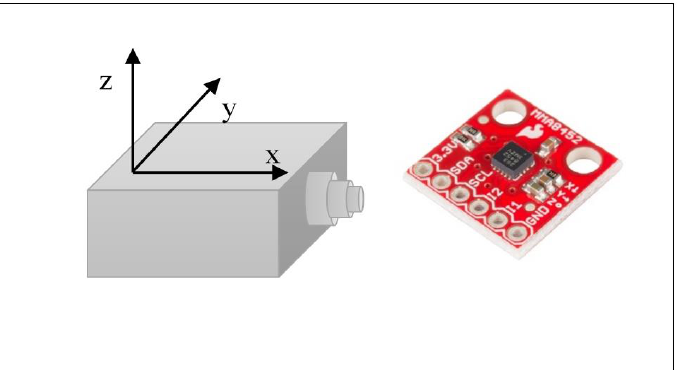
Figure 1. A triaxial accelerometer measures the vibration in three perpendicular planes (X, Y, and Z) simultaneously .